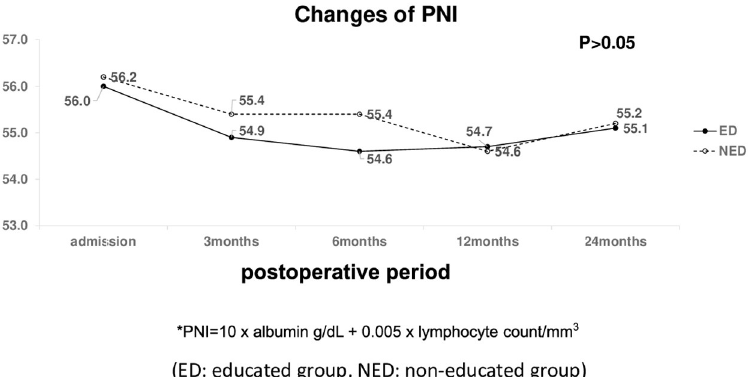
Fig 4. Changes of Prognostic Nutritional index � (PNI) according to dietary education. � PNI = 10 × albumin (g/dl) + 0.005 × lymphocyte count/mm 3 ; ED: Educated group; NED: Non-educated group.